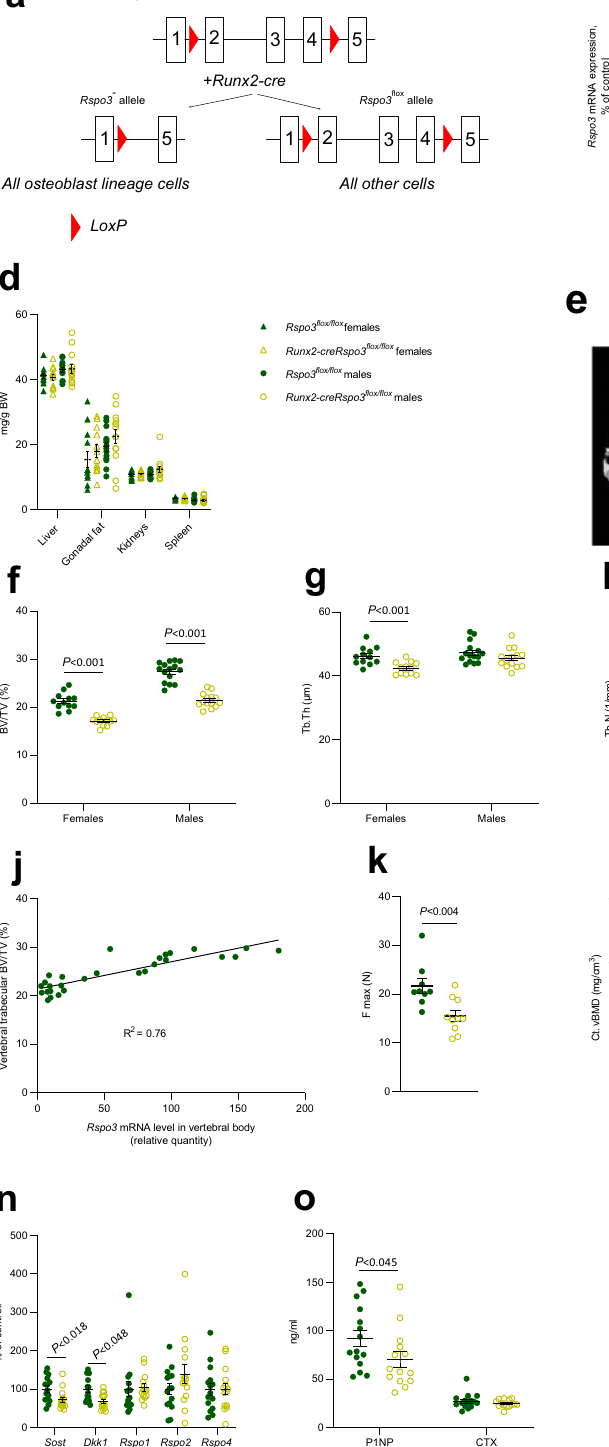
observed on cortical volumetric BMD or cortical thickness in the femur diaphysis (Fig. 3l, m). Expression analyses in the vertebral body revealed reduced mRNA levels of the two WNT signaling inhibitors Sost and Dkk1 (Fig. 3n), suggesting a compensatory mechanism to counteract additional trabecular bone loss in the adult Runx2-creRspo3 fl ox/ fl ox mice with